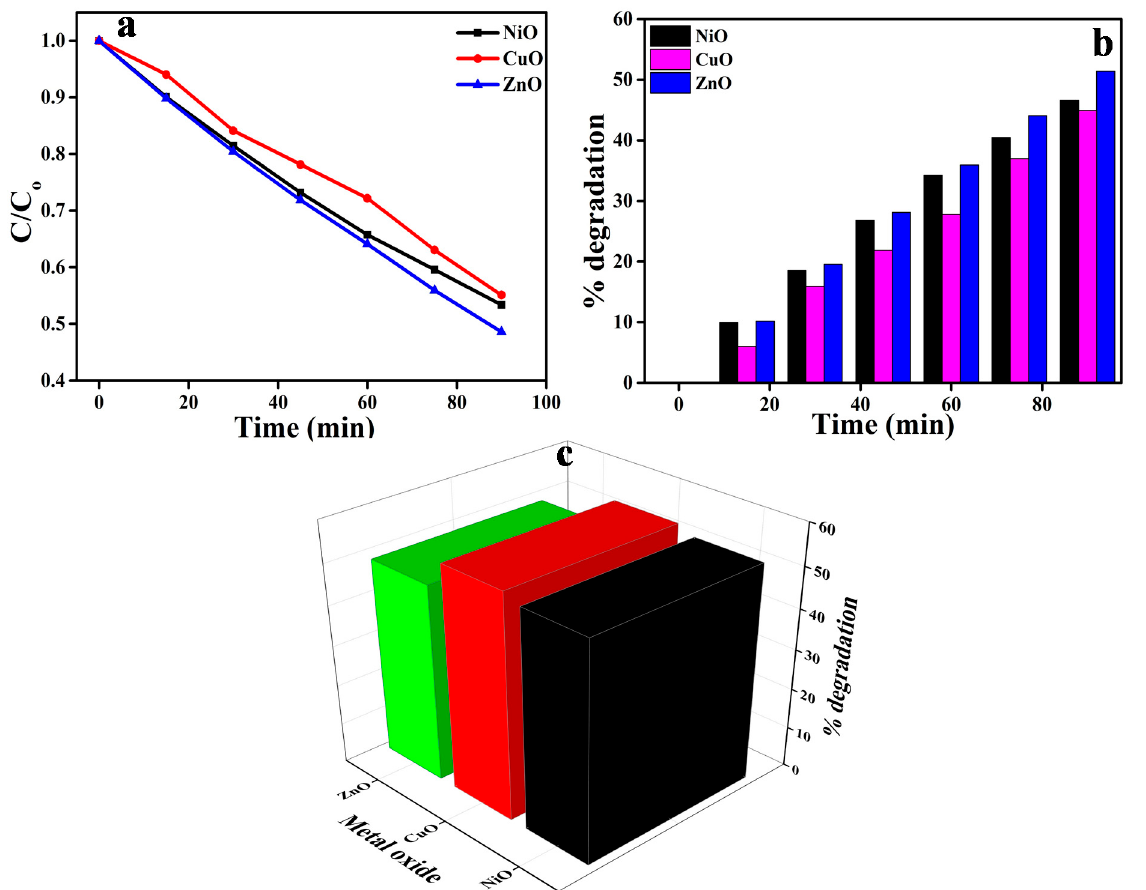
Figure 7. (a) . Effect of metal oxides on the degradation of AR88 dye. (b). Percentage degradation with a time interval of 15 Figure 7. ( a ) Effect of metal oxides on the degradation of AR88 dye. ( b ) Percentage degradation with a time interval of minutes. (c). Degradation percentage of metal oxides on AR88 dye. 15 min. ( c ) Degradation percentage of metal oxides on AR88